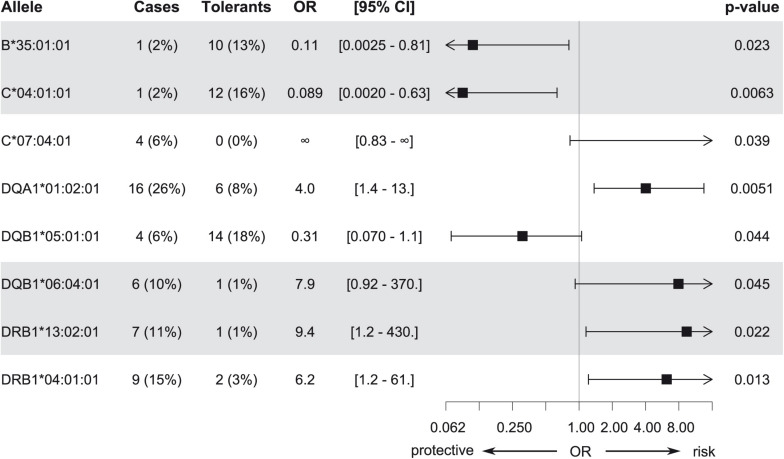
Candidate alleles with evidence for association with MIA/MIN (p < 0.05) in the discovery subset at three-field resolution. Odds ratios (OR), 95% confidence intervals, and unadjusted p-values are shown.